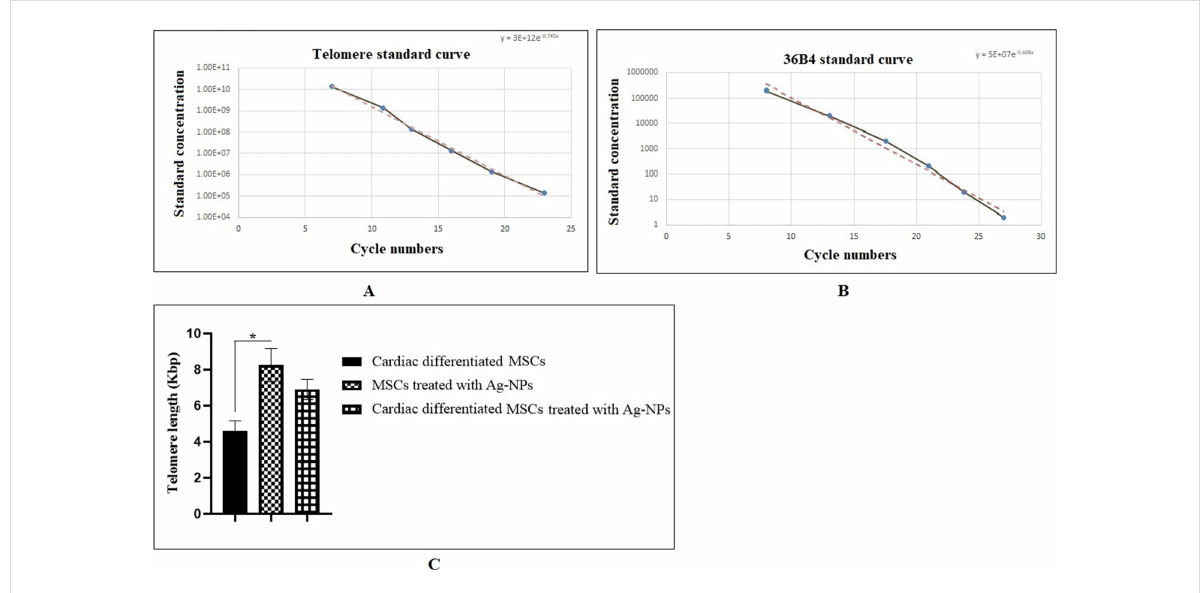
Figure 5: aTL measurement of cardiomyogenically differentiated BM-MSCs. (A) Standard curve for calculating the aTL sequence per reaction tube; (B) standard curve for calculating genome copies using the 36B4 copy number (The x -axis represents the number of the cycle and the y -axis shows the concentration of the standard). (C) Real-time PCR was carried out with 20 ng/ μ L of DNA from three groups for evaluating the aTL in triplicate (* p < 0.05; compared with control group, n = 3). The data were analyzed as kb/reaction and the genome copies/reaction for the telomere and the SCG.